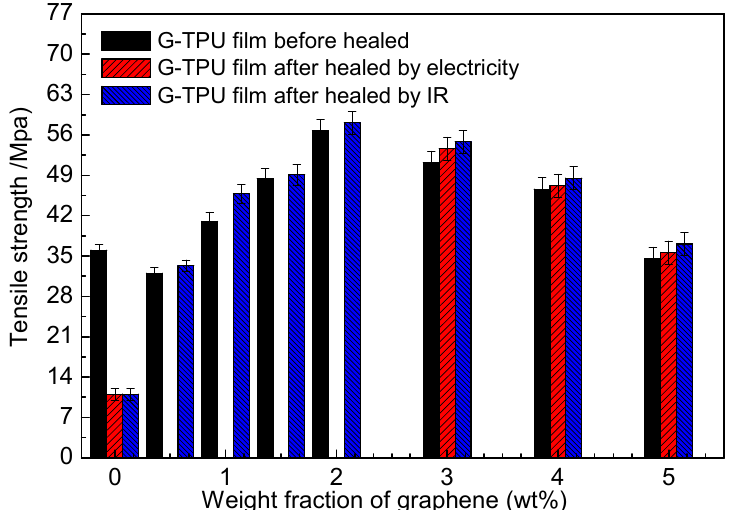
Figure 11. Tensile strength of G-TPU composite films before and after healed by electricity and IR light, respectively.